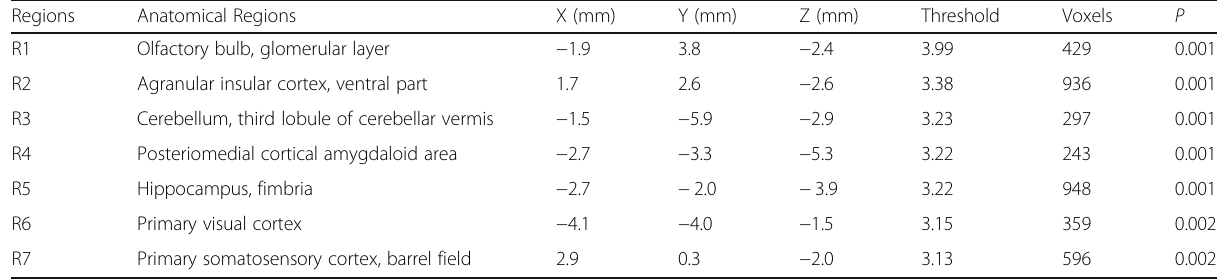
Table 3 Regional metabolic activity was decreased in WT mice after binge alcohol. Regions identified using two way ANOVA by SPM with decreases in metabolic activity in WT mice post-alcohol ( T = 2.4, P < 0.01)